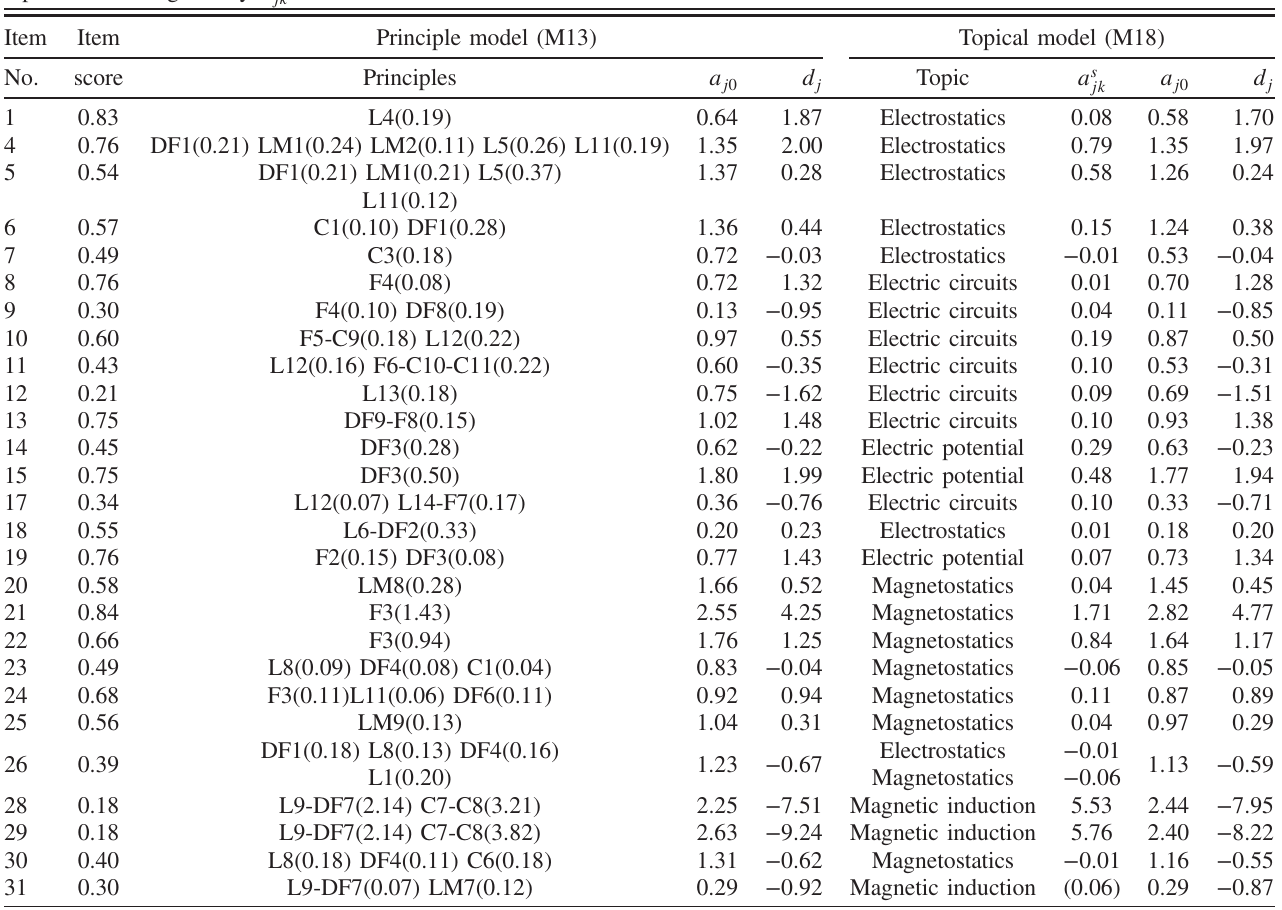
TABLE VI. Best-fitting principle and topical MIRT models. The first column shows the item number (No.). Not all items of the BEMA were modeled. The discrimination for principle k on item j , a jk , is given by the number in parentheses following the principle label. The overall discrimination of item j on a knowledge of electromagnetism is given by a j 0 . The difficulty of each item is related to d d d j ; items with larger positive j are easier, items with more negative j , harder. The discrimination of the item on the subtopics of the topical model is given by a s jk